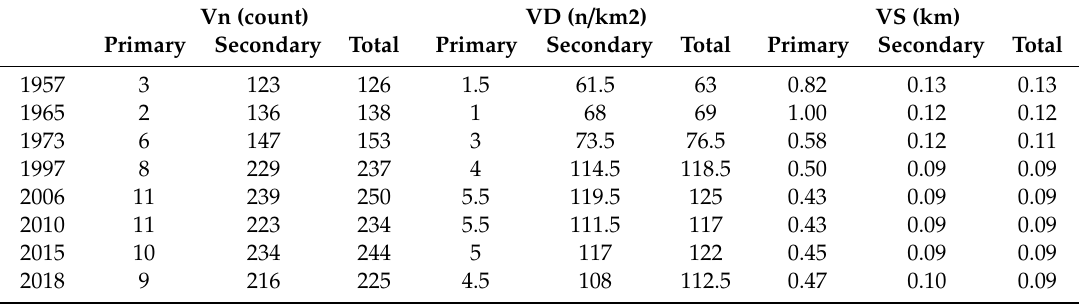
Figure 9. The viewpoint spatial arrangement resulting from MIS analysis, with the size of viewpoint referring to its rank (as explained in Figure 1): ( A ) open riverside landscape with a linear arrangement of three main viewpoints, expanded in 1965 ( B ) with an additional viewpoint on the river in the northern part of the research area, maintained practically until 1973 ( C ), but at the beginning of the succession, gradually fragmented with separation landscape interiors in the center of the research area ( D , E ), which remained in visual connectivity with the entire area until 2010 ( F ) then became ( G , H , marked in blue) visually isolated. Table 4. The results of imageability indicator value calculations. VD—viewpoint density; VS—viewpoint spacing.